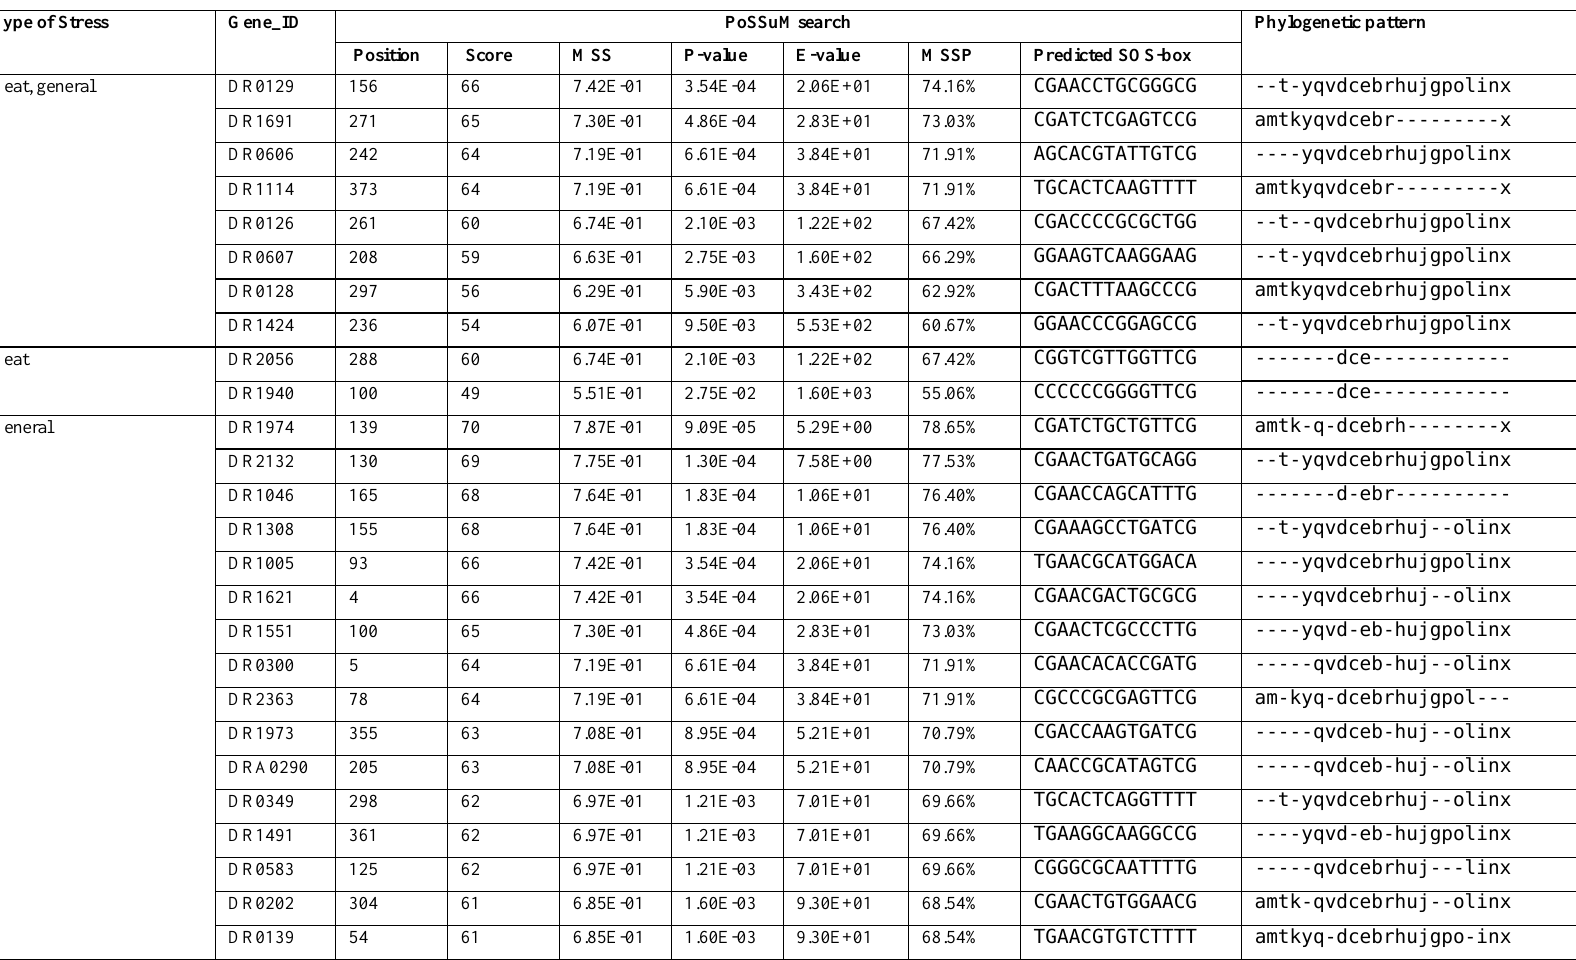
Supplementary Table 9 (S9): Details of SOS-box motifs predicted in the upstream sequences of D. radiodurans genes related to stress response through